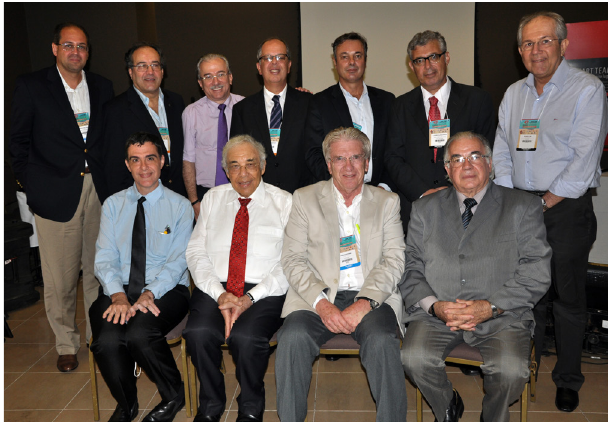
Fig.e 1 - Participants of the meeting of the Editorial Board of the Brazilian Journal of Cardiovascular Surgery at the 41st Congress of the BSCVS in Porto de Galinhas, PE. Standing, from left to right: Dr. Mauro Paes Leme de Sá, Dr. Manuel Antunes, Dr.